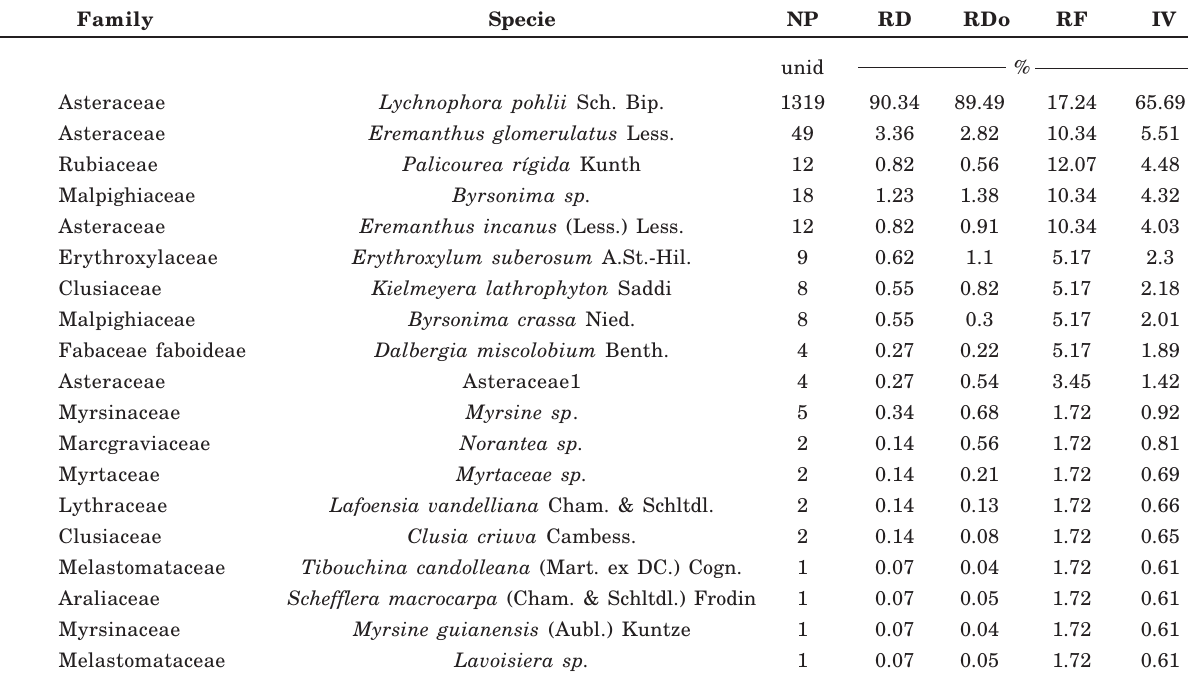
Table 1. Phytosociological parameters of the species sampled on 10,000 m² rocky grassland in the